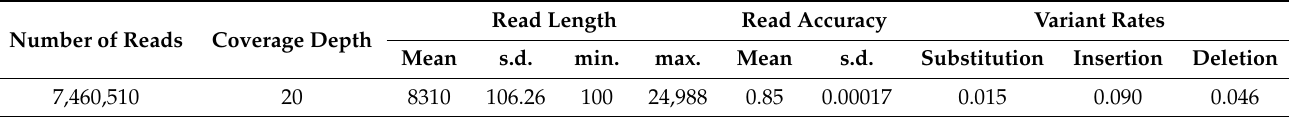
Table 1. Statistics of long reads generated with PBSIM in sampling